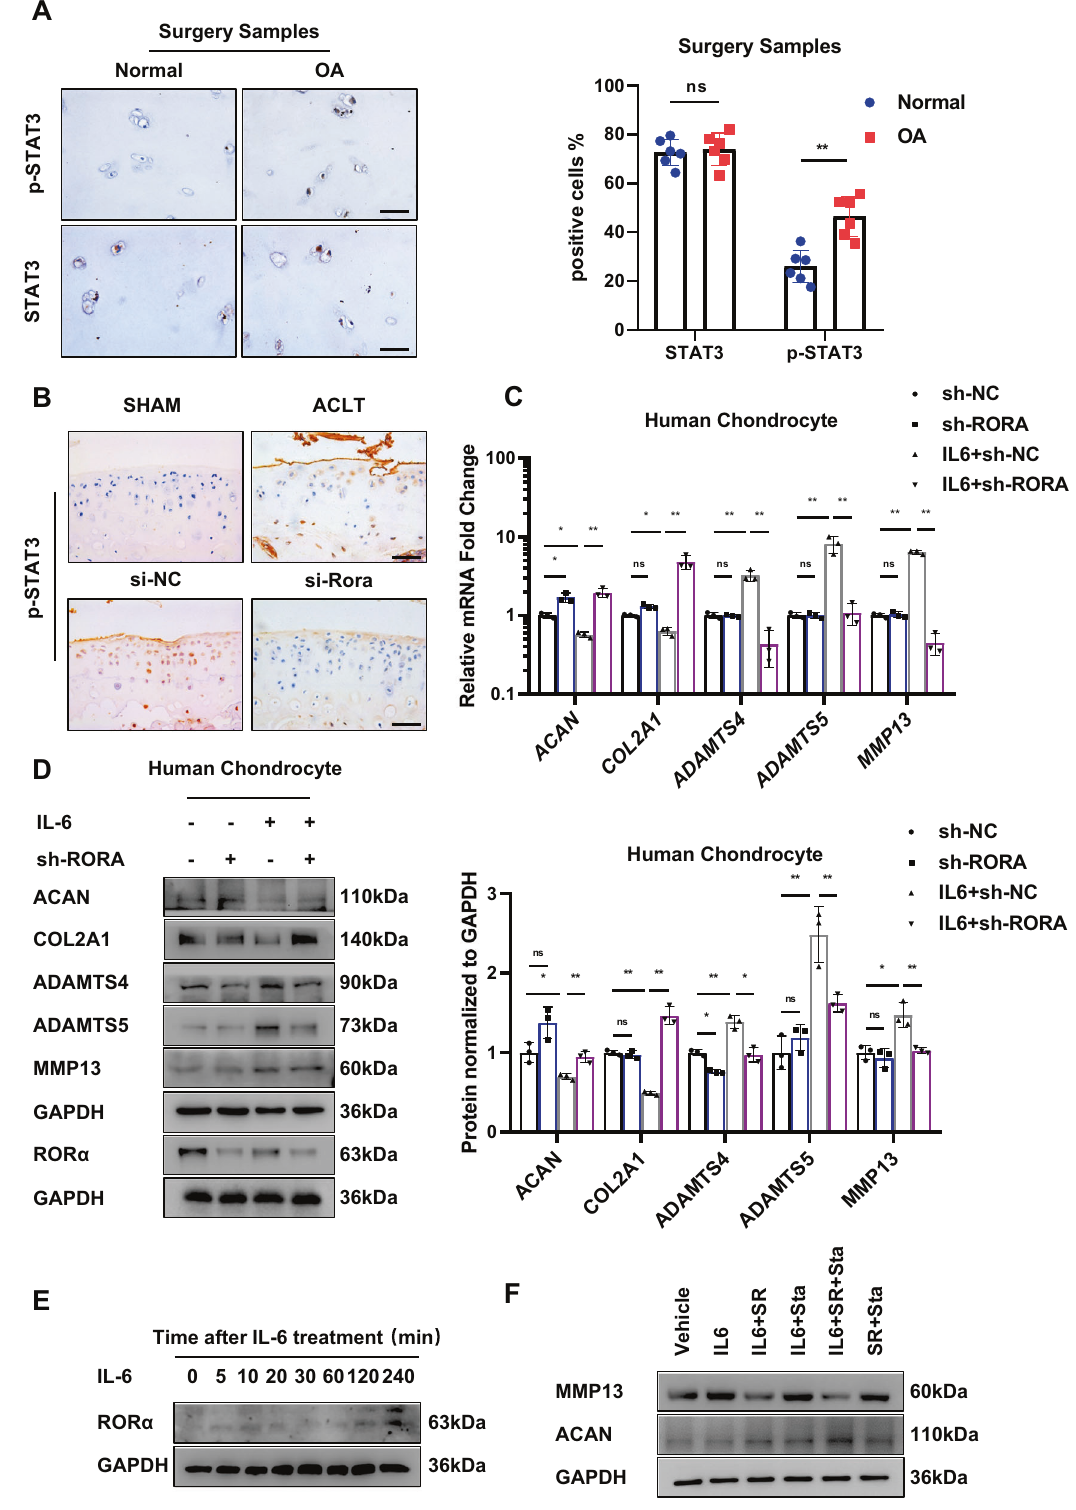
regulating the expression of matrix components and degrading enzymes. However, this study did not reveal the role of the above- mentioned ROR α endogenous ligands in modulating OA patho- genesis. Further studies should address the clinical relevance between these ligands and OA